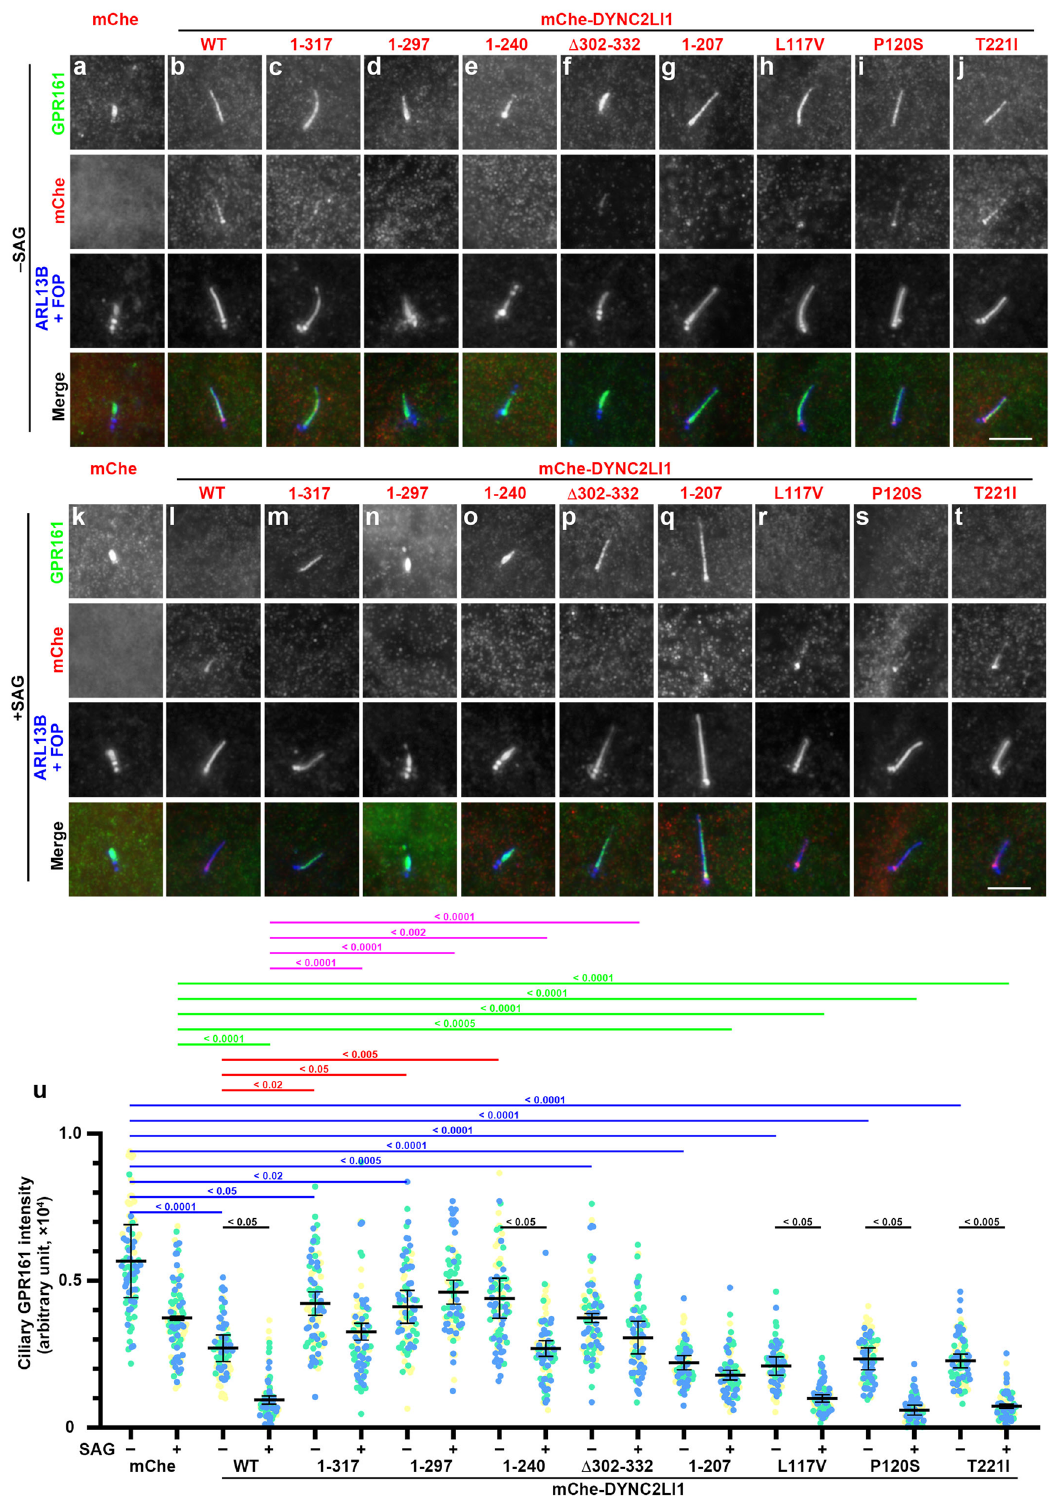
Figure 3. Effects of the expression of DYNC2LI1 variants on basal ciliary level and induced ciliary exit of GPR161 in DYNC2LI1 -KO cells. ( a – t ) DYNC2LI1 -KO cells expressing mChe ( a , k ), or mChe-fused DYNC2LI1 constructs as indicated ( b – j , l – t ) were serum-starved for 24 h to induce ciliogenesis, cultured in the absence ( a – j ; –SAG) or presence ( k – t ; + SAG) of SAG for a further 24 h, and immunostained with antibodies against GPR161 and ARL13B + FOP. Scale bars, 5 µm. ( u ) Relative ciliary staining intensities of GPR161 were estimated and expressed as scatter plots. Different colored dots represent three independent experiments ( n = 30 × 3), horizontal lines are means, and error bars are SD. Statistical significances among multiple cell lines were calculated using one-way ANOVA followed by the Dunnett’s multiple comparison test, and those between two groups (–SAG and + SAG) were calculated using the Student t